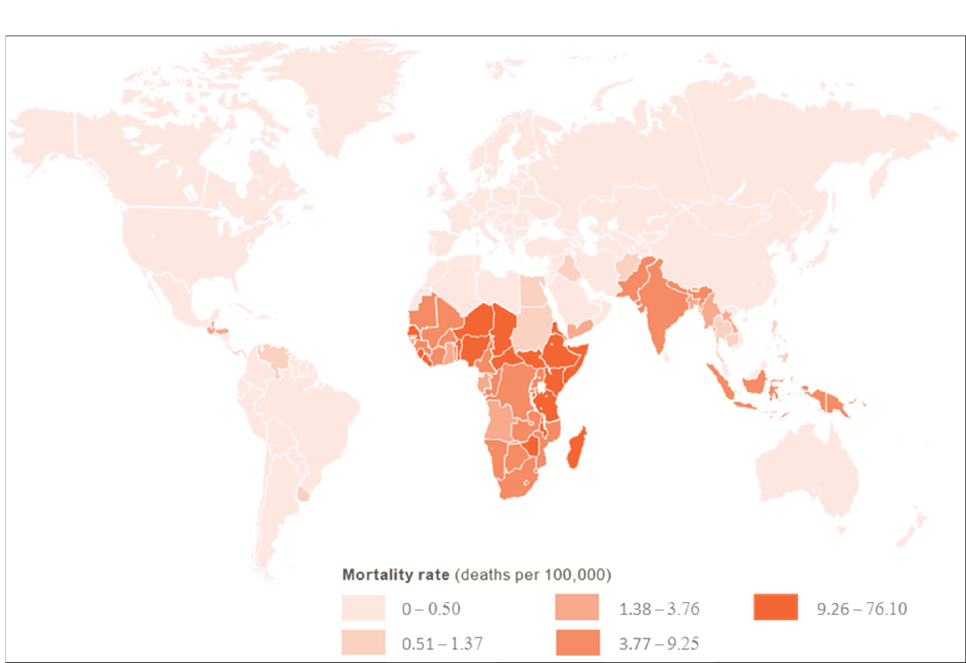
Shigellosis rates in high-income countries (HICs) are much lower, at around 0.01 per Figure 2. Infectious cycle of Shigella . 100 person-years among all ages and 0.02 per 100 person-years among children [30]. Figure 2. Infectious cycle of Shigella .